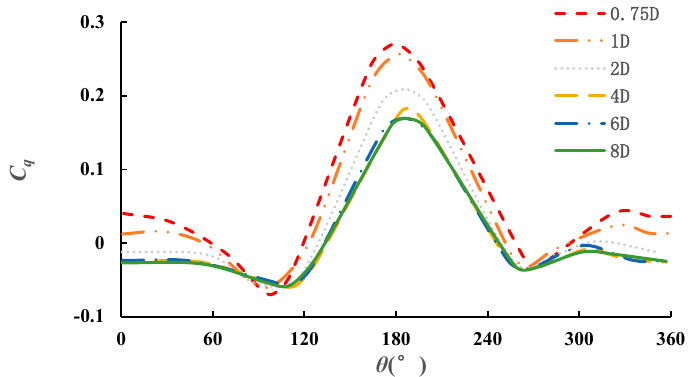
Figure 8. Variation trend of torque coefficient of single turbine with phase angle and varying D w for slip wall.